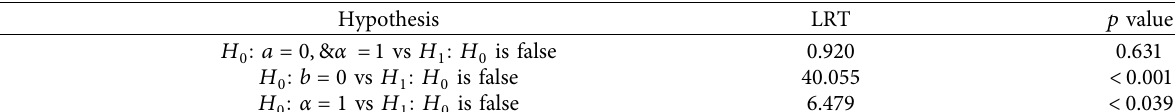
Table 14: The LRT statistic for COVID-19 fatality rate data.